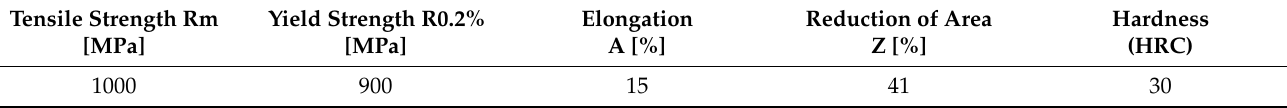
Table 3. Mechanical properties of Ti6Al4V titanium